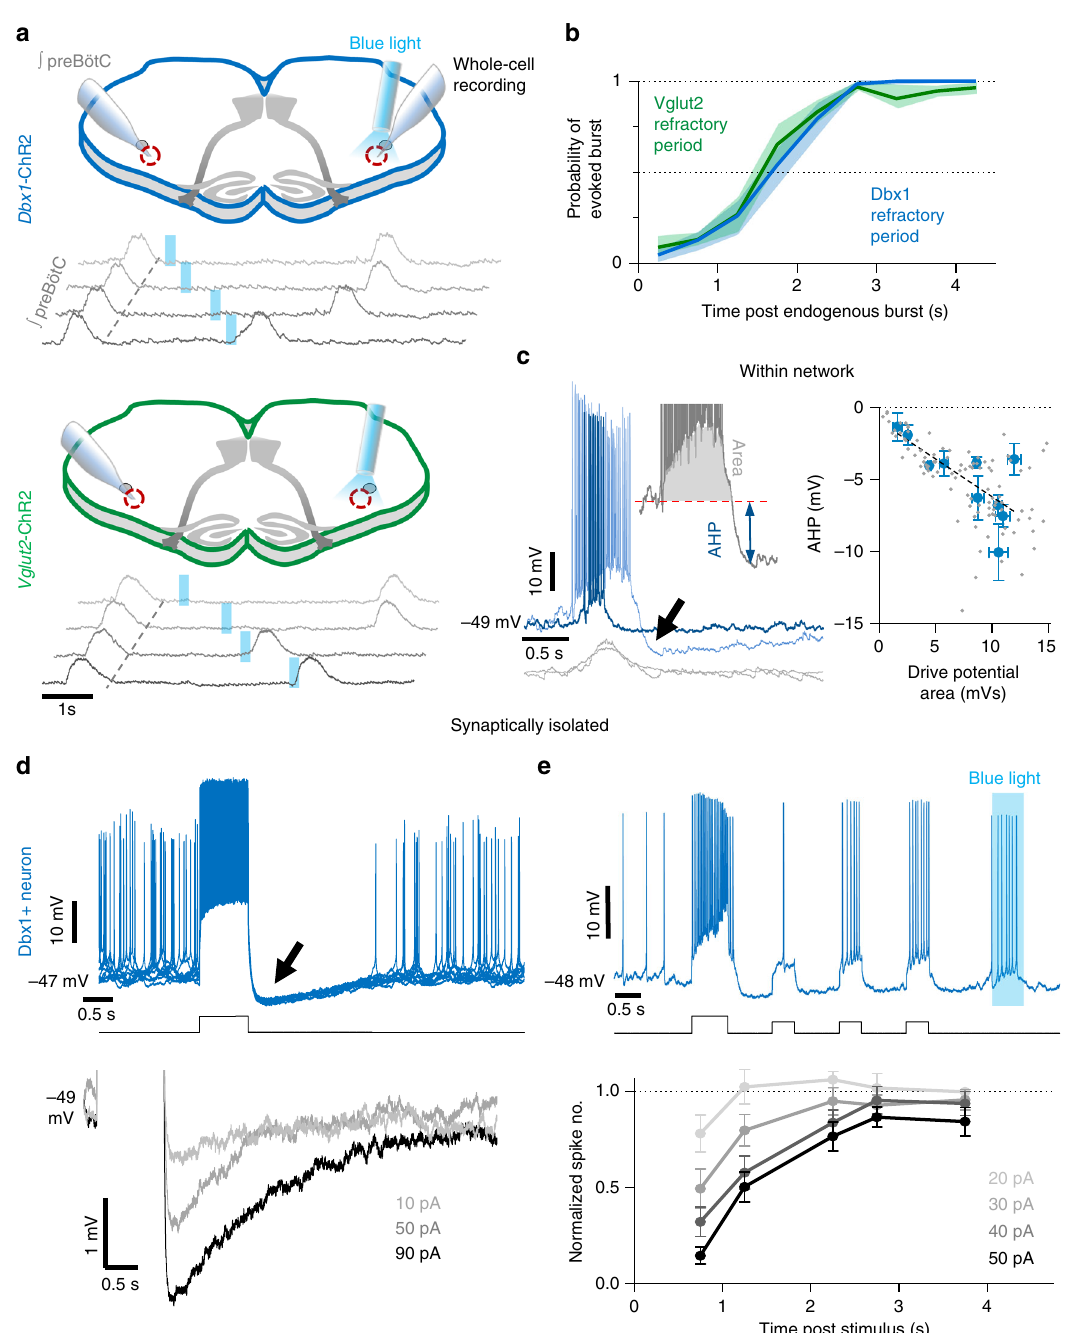
Fig. 2 Intrinsic refractory properties of preBötC neurons. a Diagram of in vitro brainstem slice preparation and example of the refractory period for evoked preBötC population bursts in a Dbx1 -ChR2 and Vglut2 -ChR2 slice. b Quanti fi ed probability of light-evoking a preBötC burst by stimulation excitatory neurons in Dbx1 -ChR2 ( n = 7) and Vglut2 -ChR2 ( n = 7) slices. ( p > 0.05 at all time points, two-way ANOVA and Bonferroni ’ s multiple comparisons test, means ± s.e.m. c Overlaid activity of two Dbx1 + neurons in the spontaneously active preBötC network demonstrating the relationship between burst drive potential and AHP (arrow). Quanti fi ed data from n = 10 Dbx1 + neurons shown on the right (linear regression analysis, p < 0.0001; slope = − 0.52 ± 0.058). d Representative example (10 overlaid sweeps) of a synaptically isolated Dbx1 + neuron showing hyperpolarization (arrow) and reduced spiking following a 600 ms 50 pA current step (upper). Membrane potential (average of 10 sweeps) before and after graded current step intensities (bottom). e Example showing transiently reduced number of spikes evoked by small (20 pA, 400ms) current steps during the intrinsic refractory period following a 30 pA current step in a synaptically isolated Dbx1 + neuron (note the depolarization and spiking evoked by light); average normalized number of spikes evoked at different time points following current steps of varied intensity ( n = 7 neurons from n = 7 slices; means ±